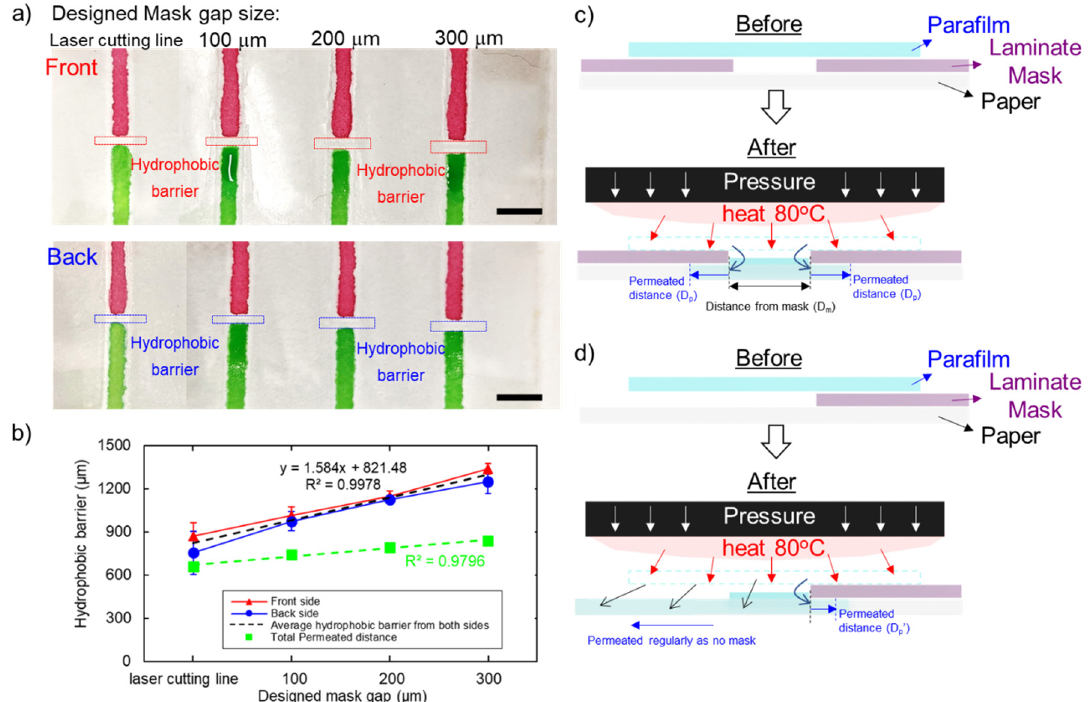
Figure 8. Resolution of hydrophobic barrier: ( a ) hydrophobic barrier is tested with food dye colours; ( b ) a linear relationship between the final hydrophobic barrier with the designed mask, indicating the smallest hydrophobic barrier size is 821 µ m; ( c ) parafilm melting into the paper through the gap of the mask; ( d ) parafilm melting into the paper through the open space of the mask. Both schematic diagrams show that the melting could be dictated by the gap in the mask (D m ) and permeated distance (D p ). Scale bar shown is 5 mm.